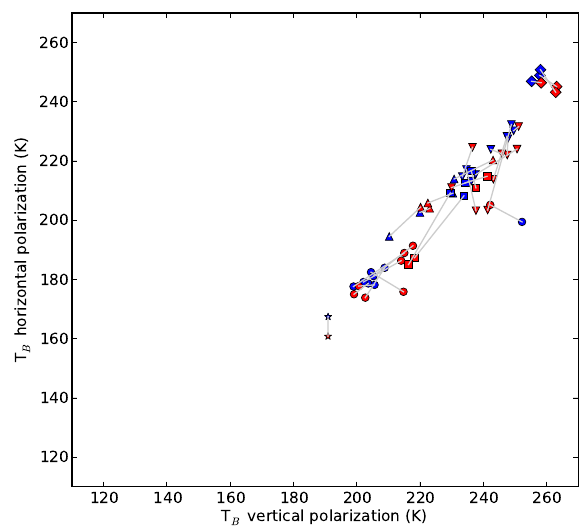
Fig. 12. Same as Fig. 11 for a frequency of